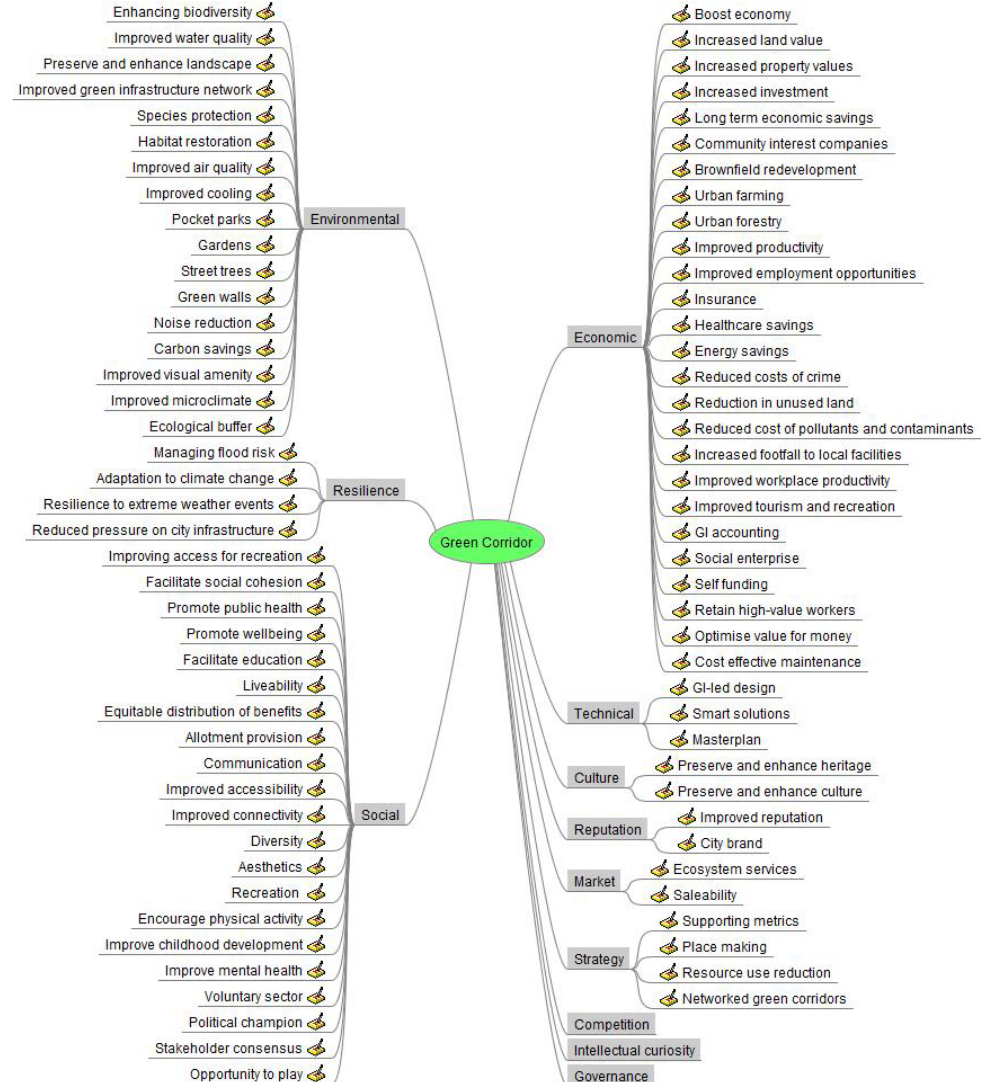
Figure 5. Generic value map identifying value generating opportunities for